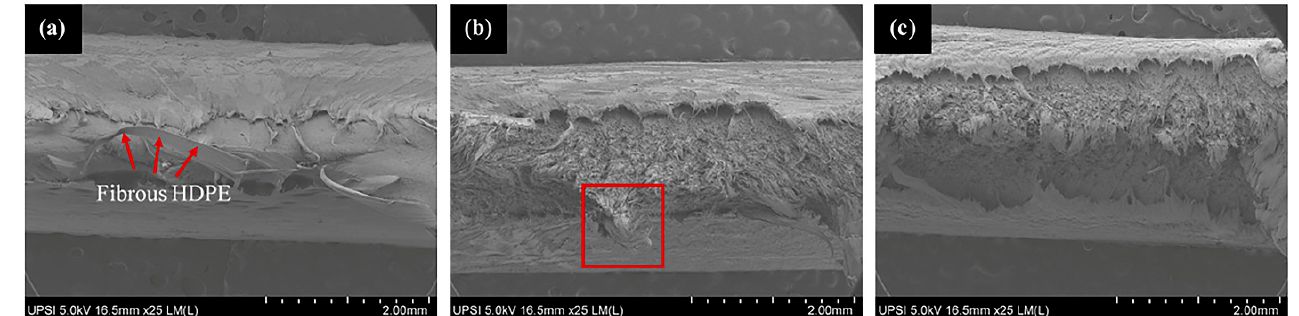
Figure 6. SEM images for the fracture surfaces of the ( a ) pure HDPE, ( b ) HDPE/30HAp, and ( c ) HDPE/30HAp-S compo- sites subjected to tensile test. ( c ) HDPE/30HAp-S composites subjected to tensile